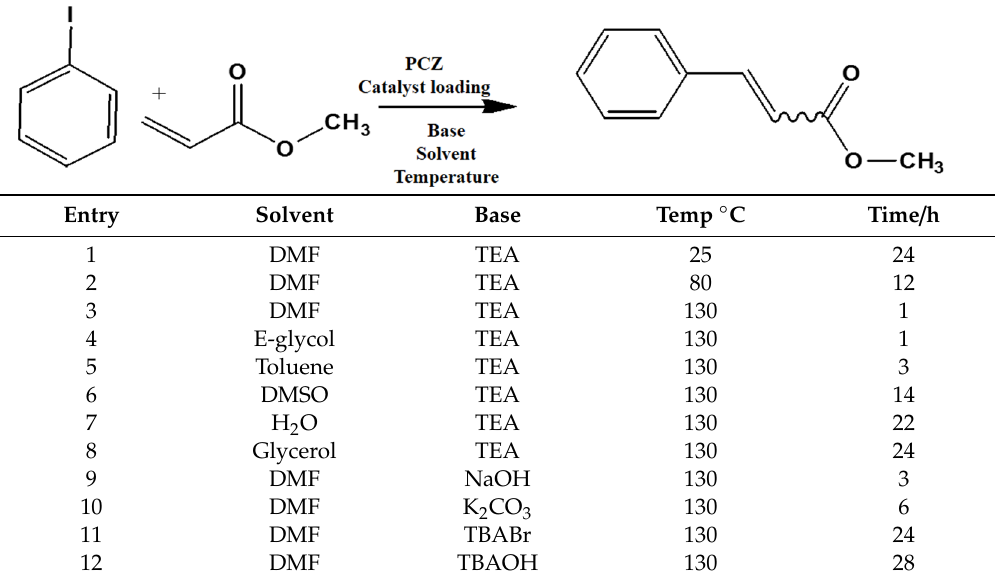
Table 4. Results of the optimisation reactions between iodobenze and methylacrylate.